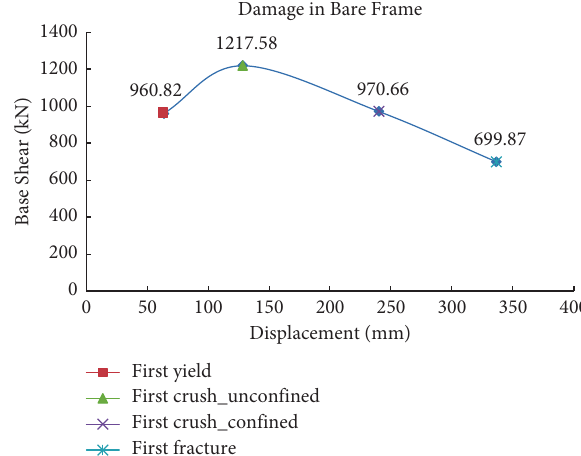
Figure 11: Damage patterns for the bare frame.